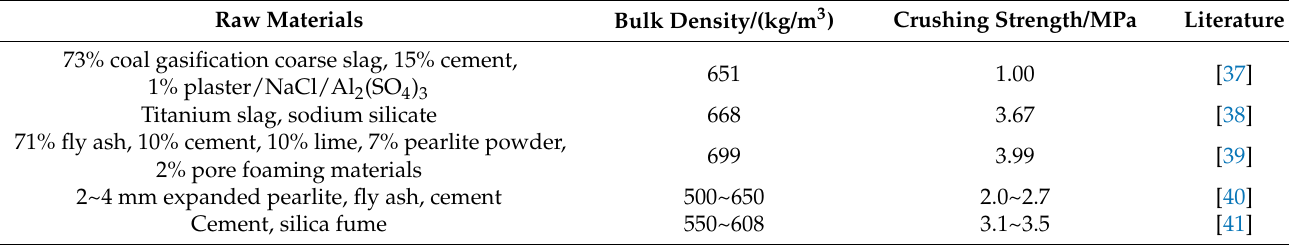
Table 8. Basic properties of other cold-bonding lightweight aggregate. Raw